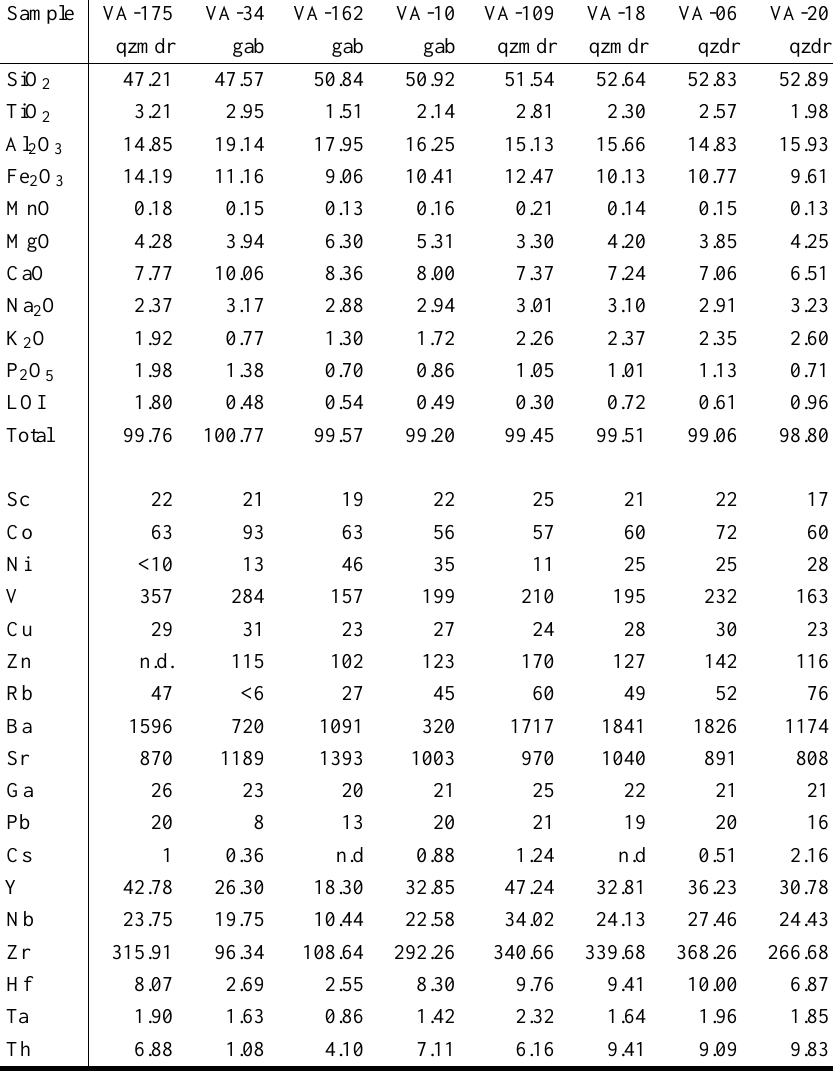
Chemical compositions of Opx-gabbro (gab), qtz-diorite (qzdr) and qtz-monzodiorite (qzmdr) from Várzea